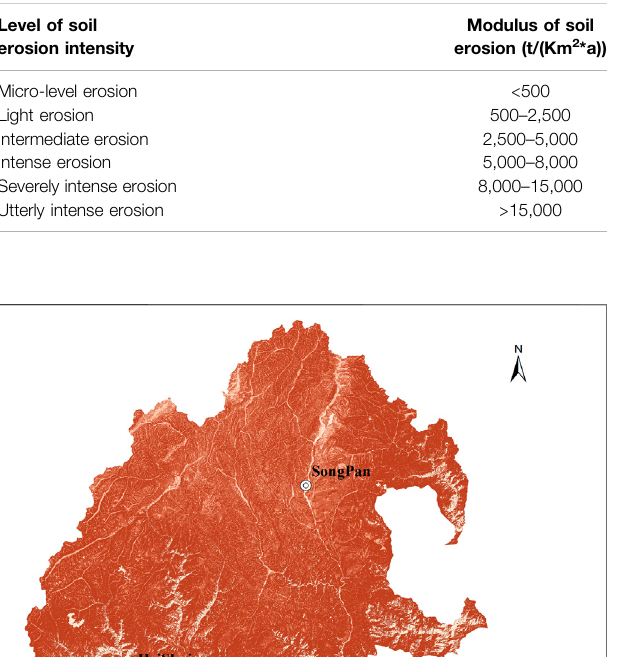
TABLE 4 | Grading of the level of soil erosion intensity.